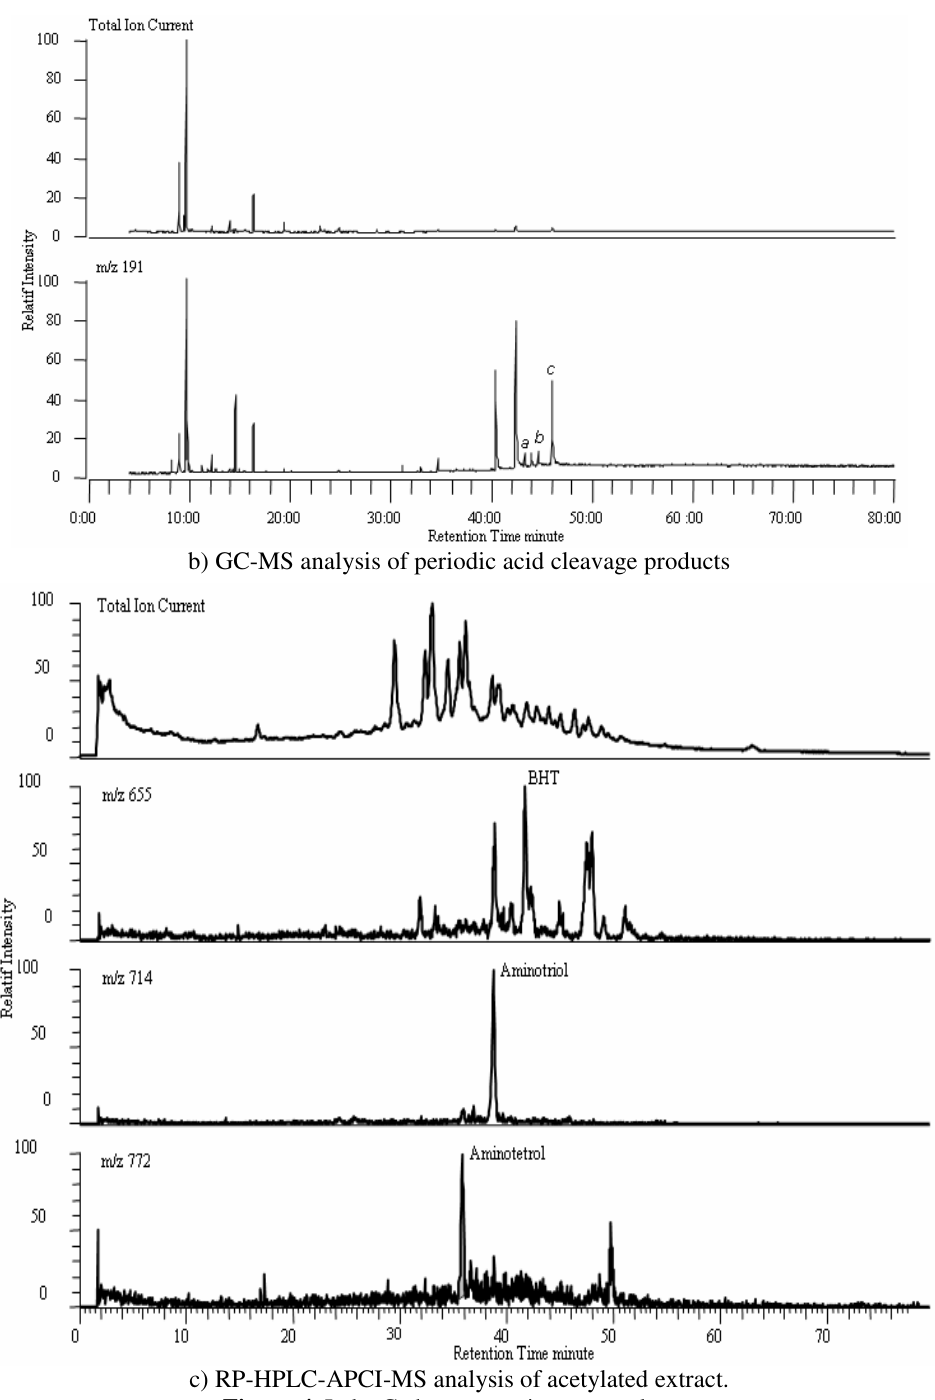
Figure 4. Lake Cadagno-anoxic zone